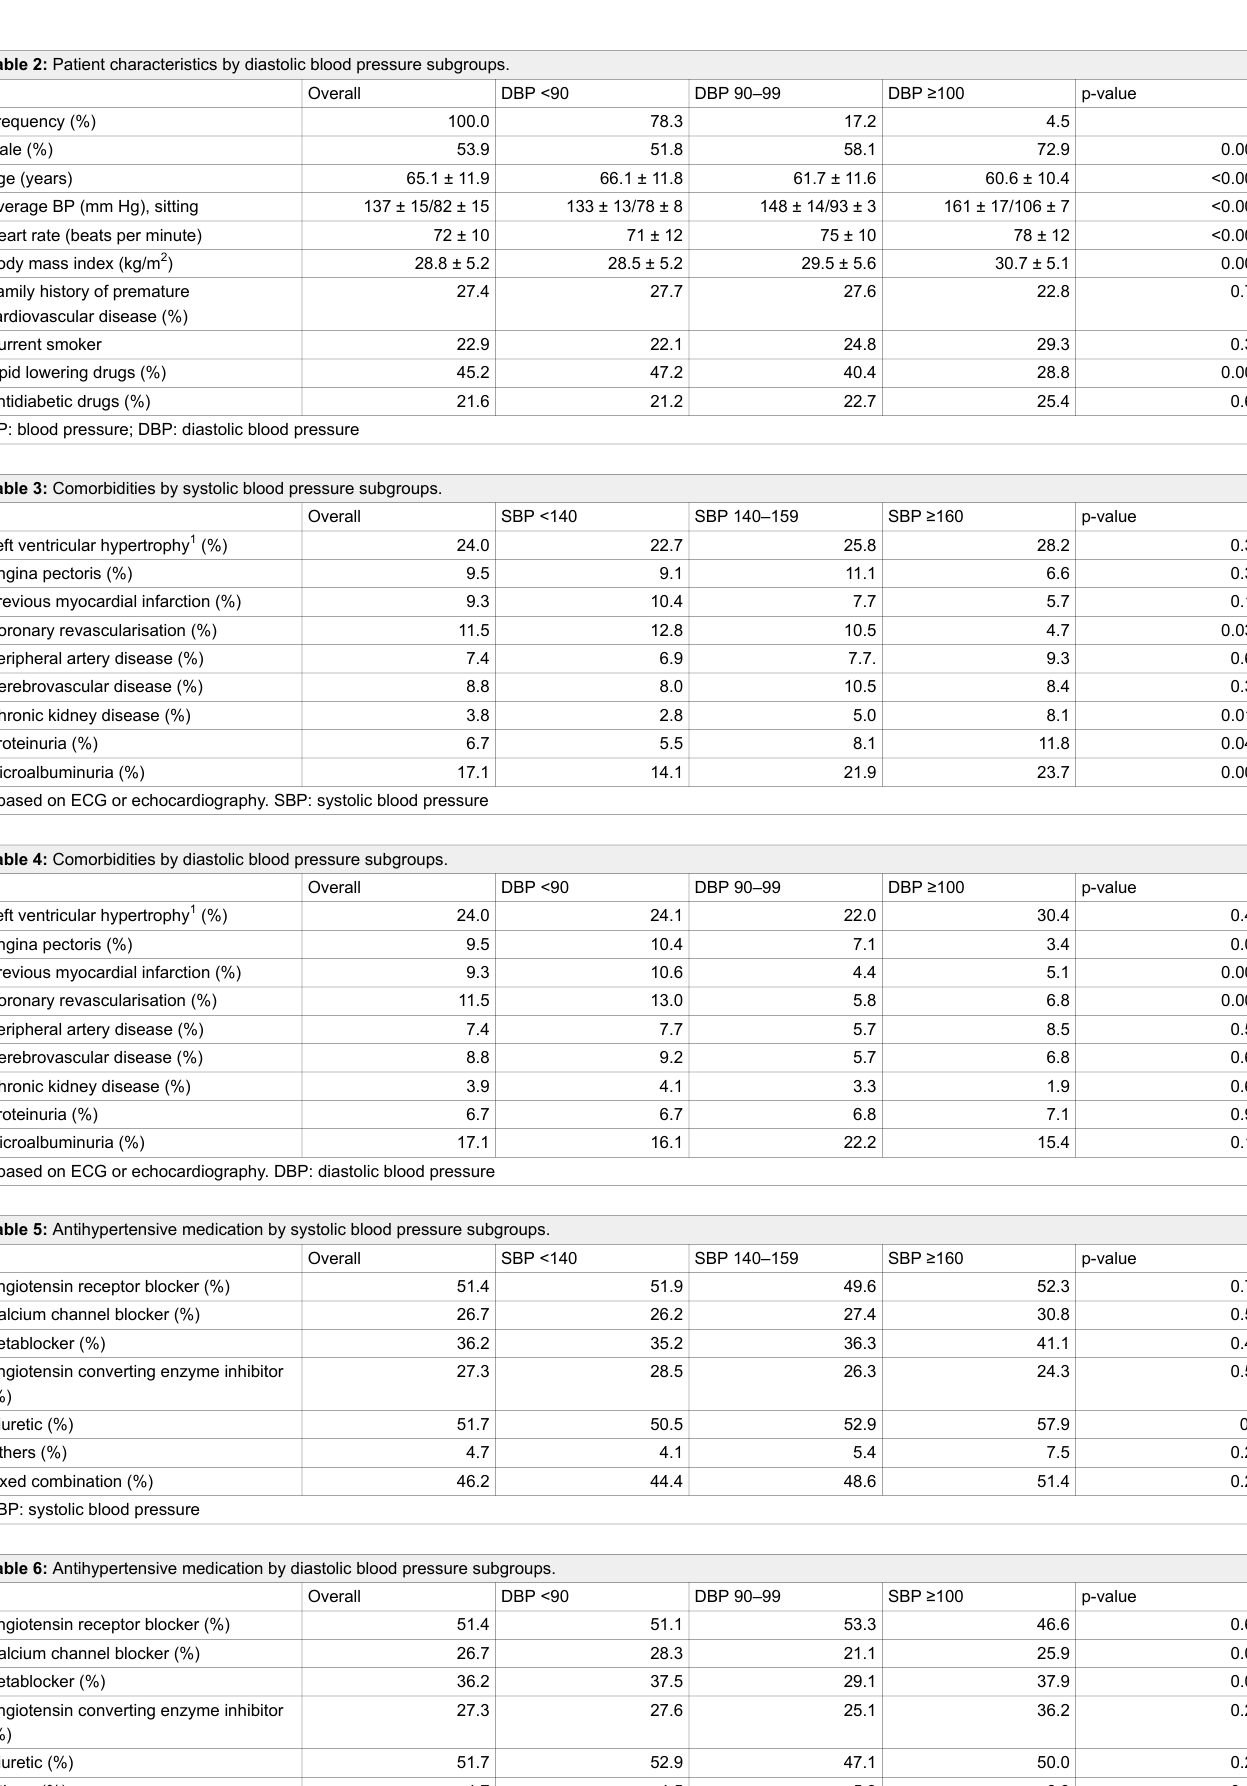
Diuretic (%) Others (%) Fixed combination